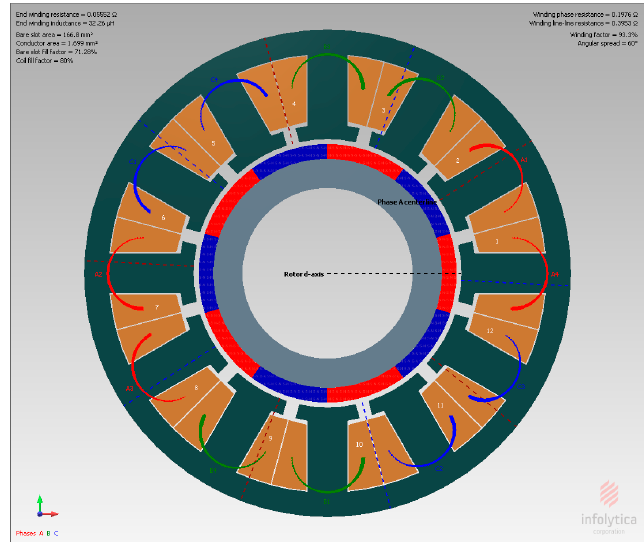
Figure 5. Non-Overlapping Winding Layout in MotorSolve.